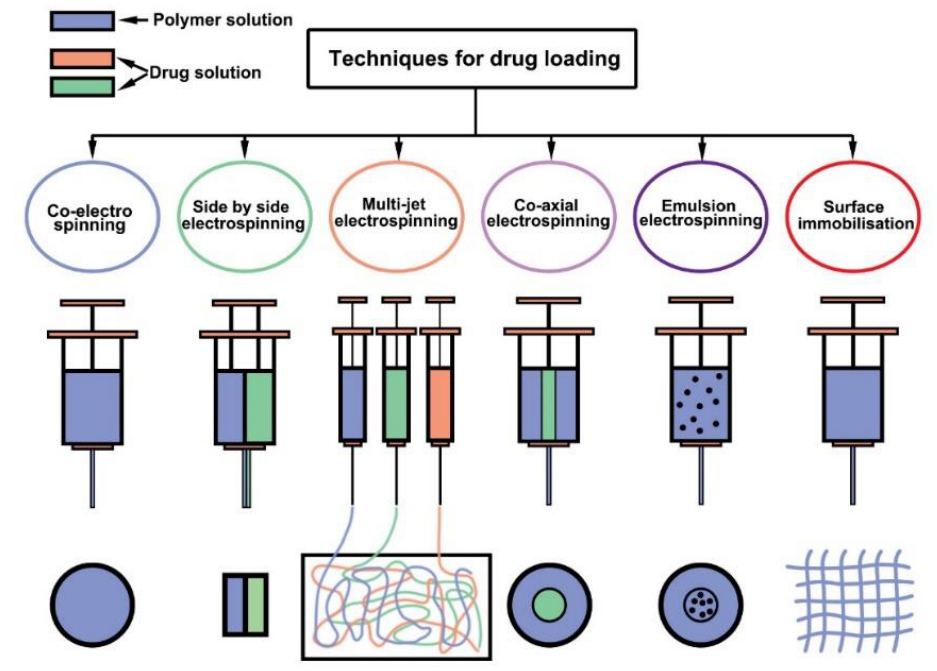
Figure 13. The scheme image of the different methods for loading the drug in nanofibers, reproduced from an open access paper [71], under the terms of Creative Commons Attribution 4.0 International (CC BY 4.0) License.